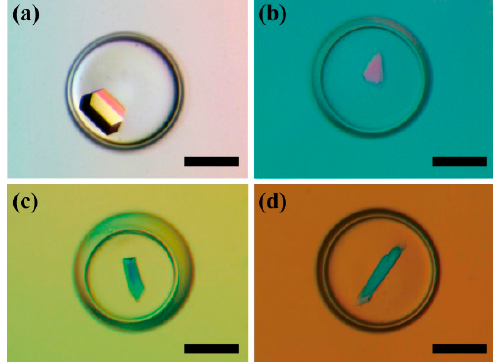
Figure 4. Protein crystallization results using the double emulsion-based approach to implement the vapor diffusion method for: ( a ) Lysozyme; ( b ) Thaumatin; ( c ) Trypsin; ( d ) Horseradish peroxidase. Scale bars: 300 μm.